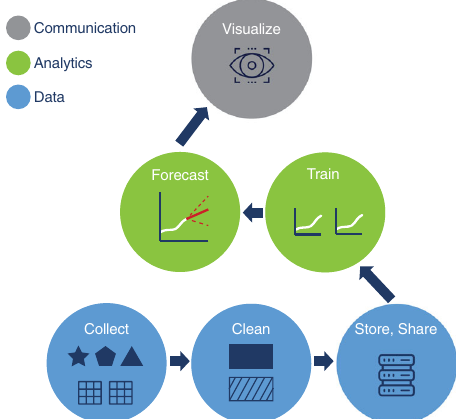
Fig. 1 The forecasting work fl ow: Generating infectious disease forecasting results that will be useful for managing outbreaks follows a work fl ow with three main strata: data (blue circles), analytics (green circles), and communication (gray circle). Taken together, these pieces build a work fl